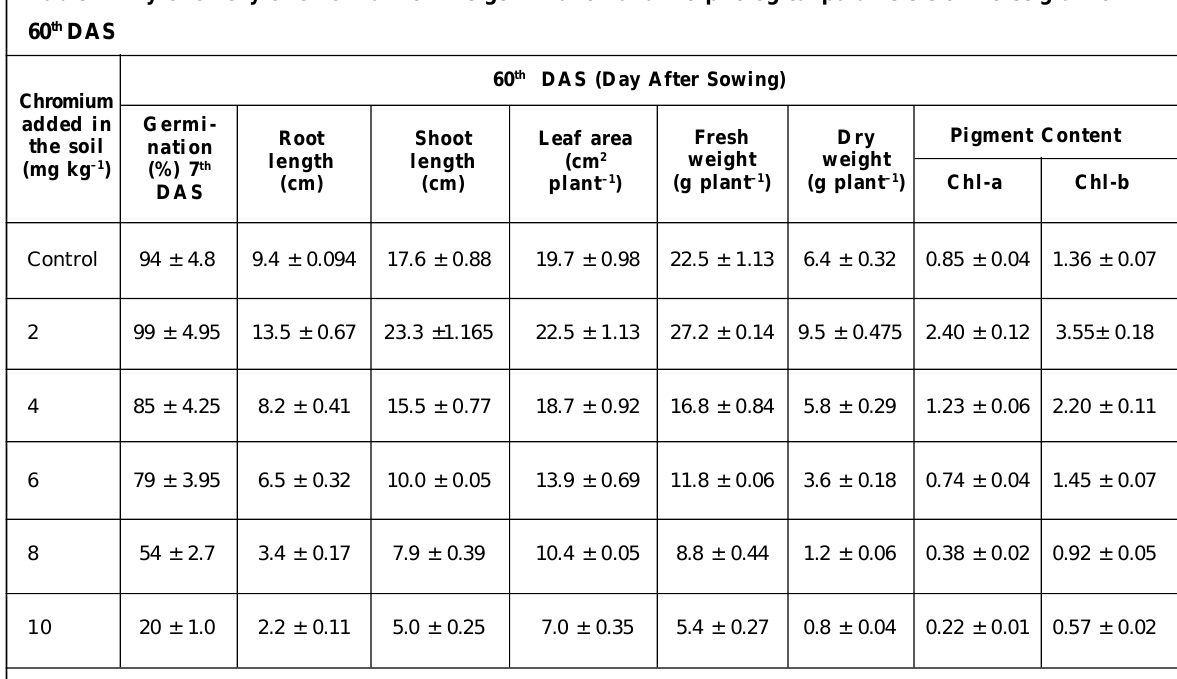
Table 1: Phyto toxicity of chromium on the germination and morphological parameters of Horse gram